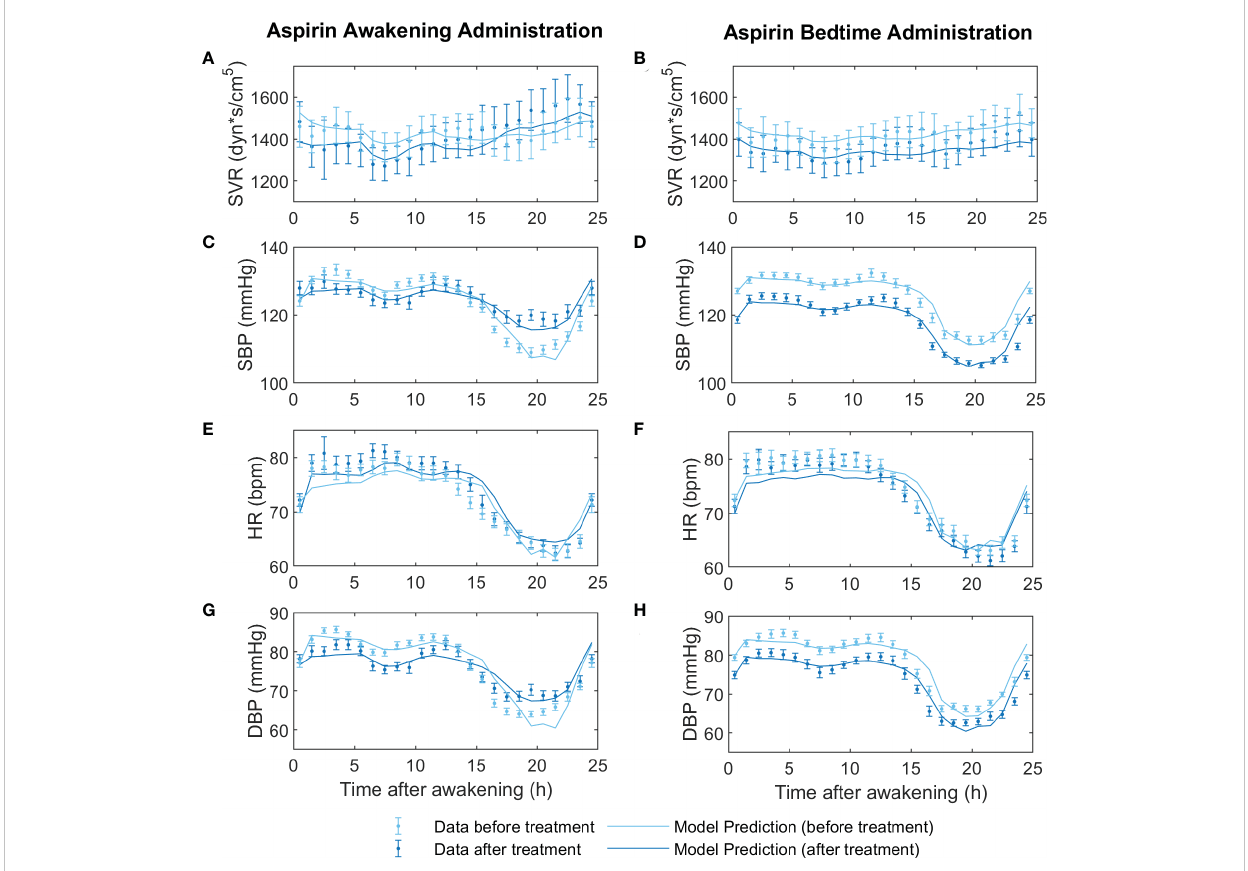
FIGURE 2 Fitting models to data before and after aspirin treatment at awakening (on the left) versus at bedtime (on the right). Before-treatment data from AM and PM administration groups were fi tted independently, to a non-Ta dependent effect model. After-treatment data were fi tted to the Ta-dependent effect model, both awakening and bedtime administration simultaneously. In panels (A, B) the dynamics of the experimental data (light red points for before treatment and dark red points for after treatment) and predictions of the models (light red line for before treatment and dark red line for after treatment) of systemic vascular resistance (SVR), (C, D) systolic blood pressure (SBP), (E, F) heart rate (HR), and (G, H) diastolic blood pressure (DBP) are